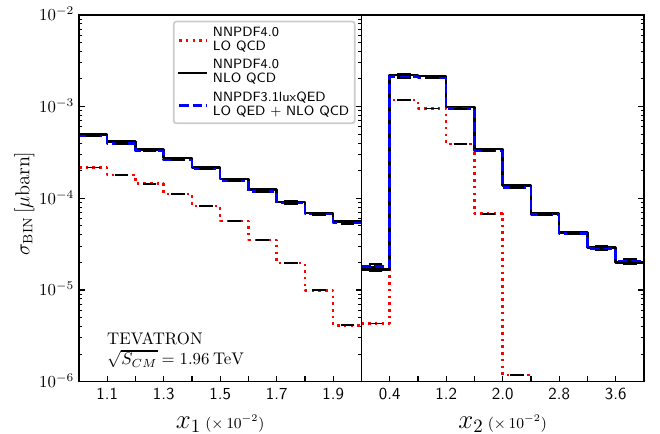
Figure 5: Cross-section as a function of the partonic momentum fraction x and x (right), for Tevatron. x corresponds to the momentum fraction associated 2 1 to the proton, whilst x to the 2